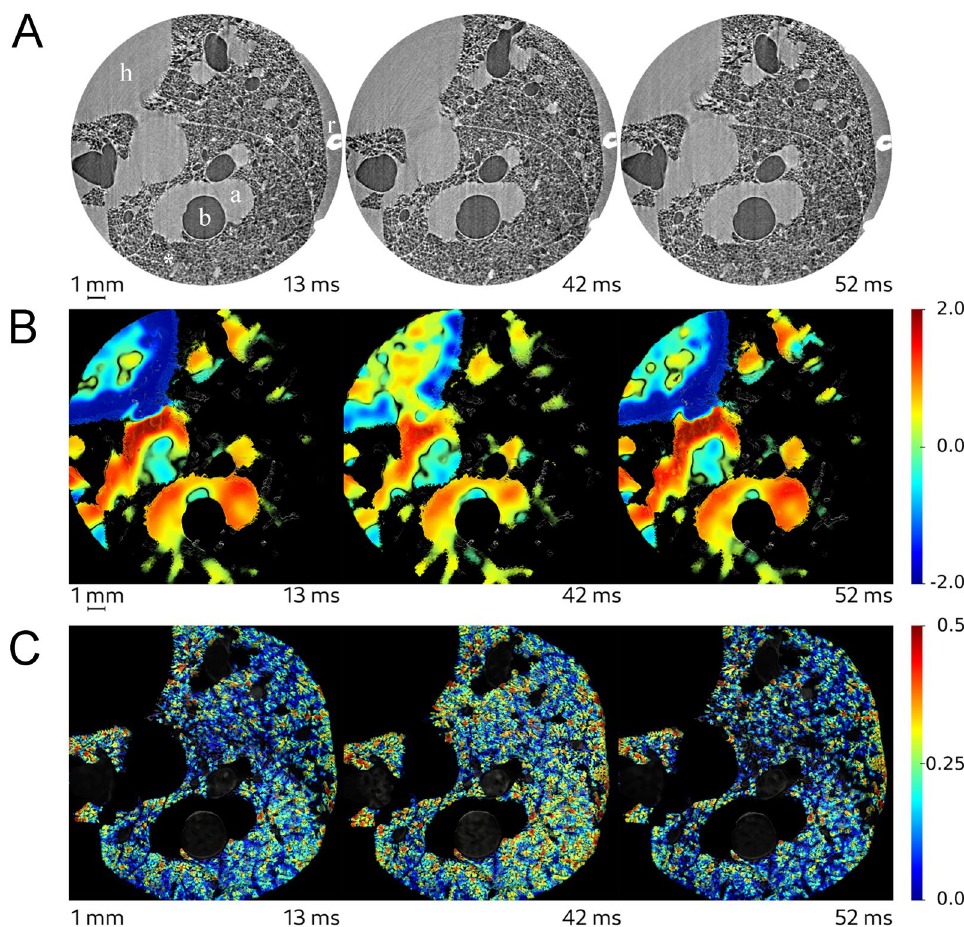
Figure 2. Quantitative mapping of lung tissue biomechanics in a live rat. ( A ) Sample sequential x-ray phase- contrast CT images at successive time points, reconstructed by retrospectively sorting of 250,000 individual image projections with respect to the phase of heart contraction and breathing, b : bronchus, a : artery, h : heart, s : interlobar scissure, r : rib, *: alveoli; ( B ) sequential local strain maps of vascular structures; ( C ) sequential regional strain maps of airspaces. Color bars indicate strain ( δV/V t0 , where t0 is the start of the breath). Corresponding video animations are provided in the online